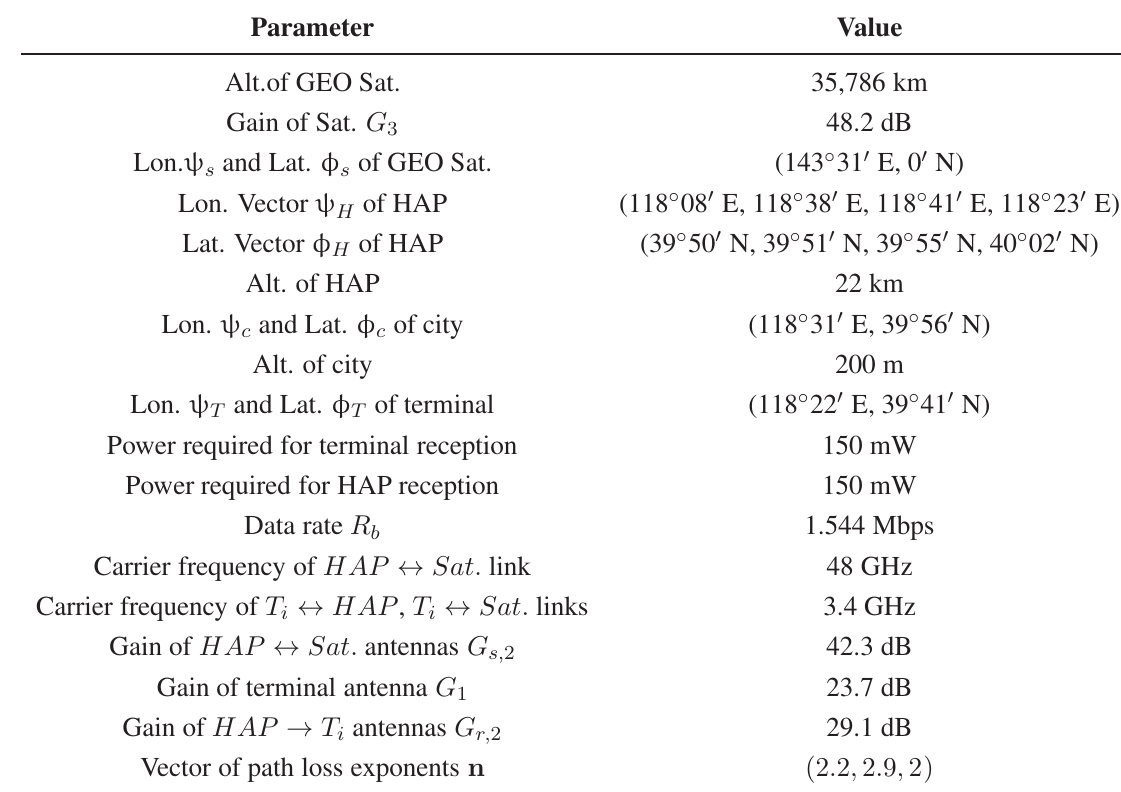
Table 2. Parameters used in the simulations and their